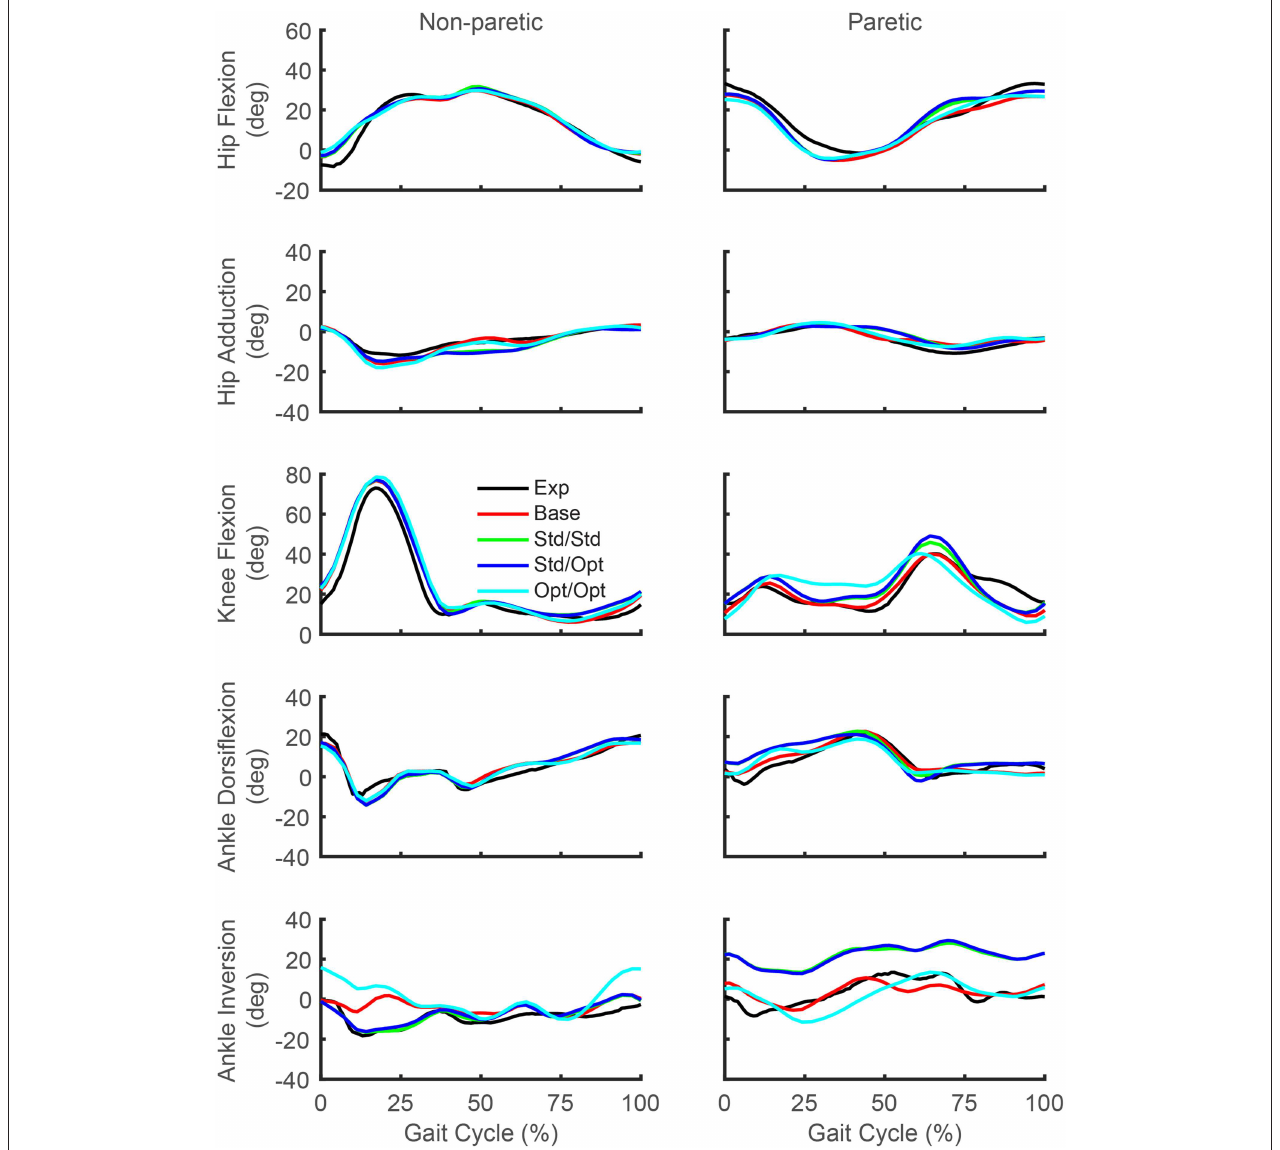
FIGURE 5 | Experimental and predicted lower body joint angles over the gait cycle. Hip flexion (first row), hip adduction (second row), knee flexion (third row), ankle dorsiflexion (fourth row), and ankle inversion (fifth row) are presented for the non-paretic leg (left column) and the paretic leg (right column). The legend is the same as in Figure 2